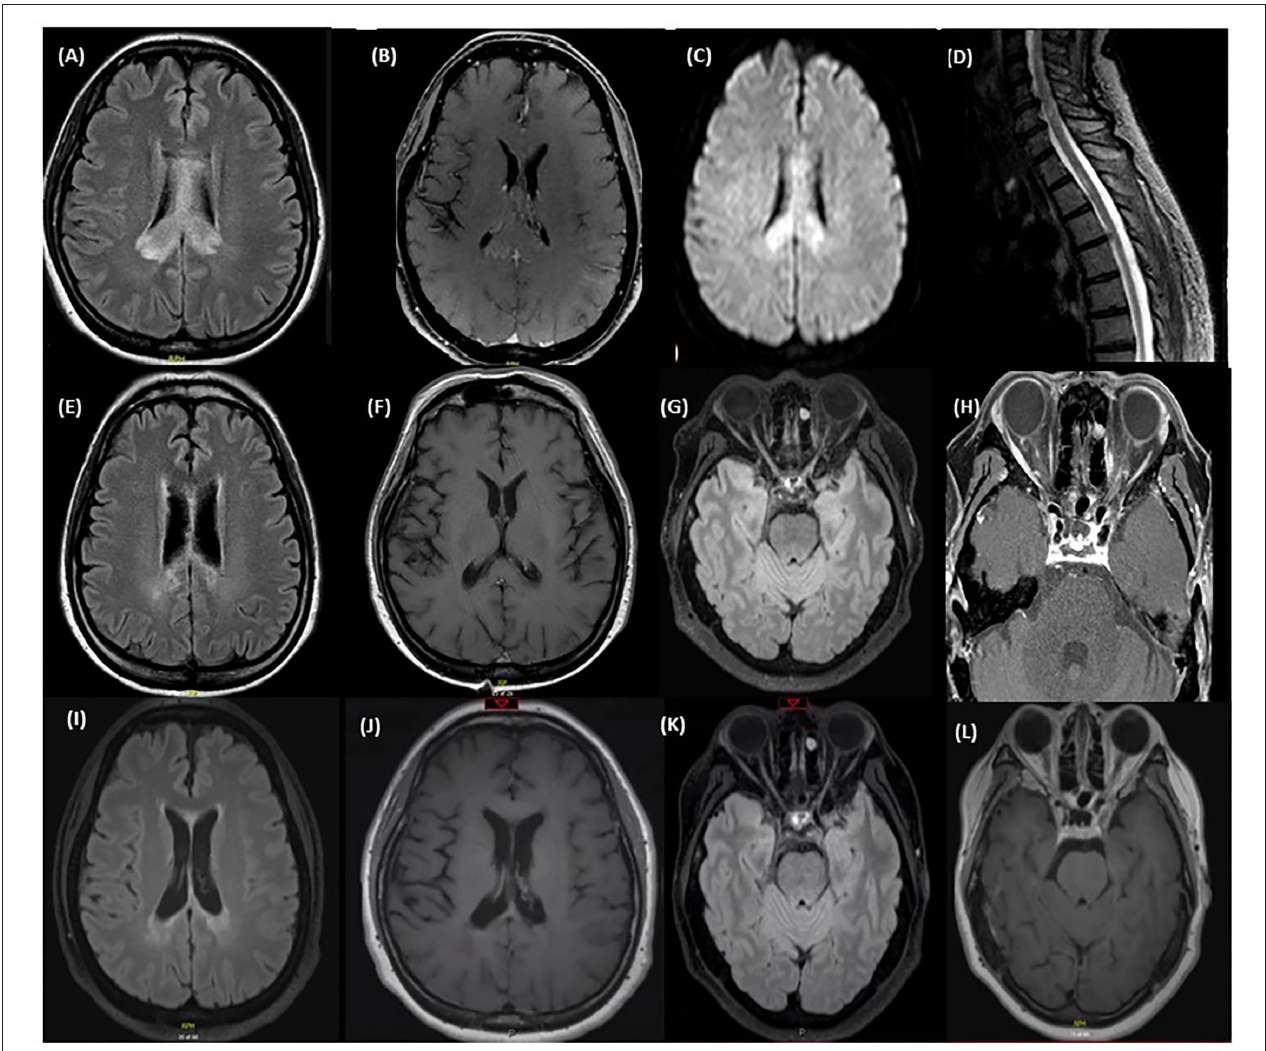
FIGURE 1 | MRI at time of first relapse: (A) Axial T2 FLAIR sequence of the brain showing diffuse corpus callosum involvement. (B) Axial T1 with gadolinum showing patchy enhancement of the lesion in the right splenium of the corpus callosum. (C) Axial DWI sequence of the brain showing diffusion restriction. (D) T2 STIR sequence of the lower cervical spine and thoracic spine showing a central hyperintensity extending from the level of T1-T3. MRI after treatment of first relapse with corticosteroids: (E) Axial T2 FLAIR sequence of the brain showing an improvement of the corpus callosum lesions after the steroid course. (F) Axial T1 with gadolinium showing a resolution of the patchy enhancement after the steroid course. MRI immediately prior to eculizumab: (G) Axial T2 FLAIR sequence of the brain showing an increased T2 signal in the right optic nerve in the mid intraorbital course with focal atrophy of the left optic nerve. (H) Axial T1 with Gadolinium sequence of the orbits before starting eculizumab showing mild enhancement of both optic nerves. MRI after eculizumab: (I) Axial T2 FLAIR sequence of the brain showing stable deep periventricular lesions without any new lesions identified. (J) Axial T1 with gadolinium showing no enhancing lesions. (K) Axial T2 FLAIR sequence of the brain showing a decrease in the intensity of the T2 signal in the right optic nerve. (L) Axial T1 with gadolinium shows resolution of the previously enhancing optic nerve lesions.